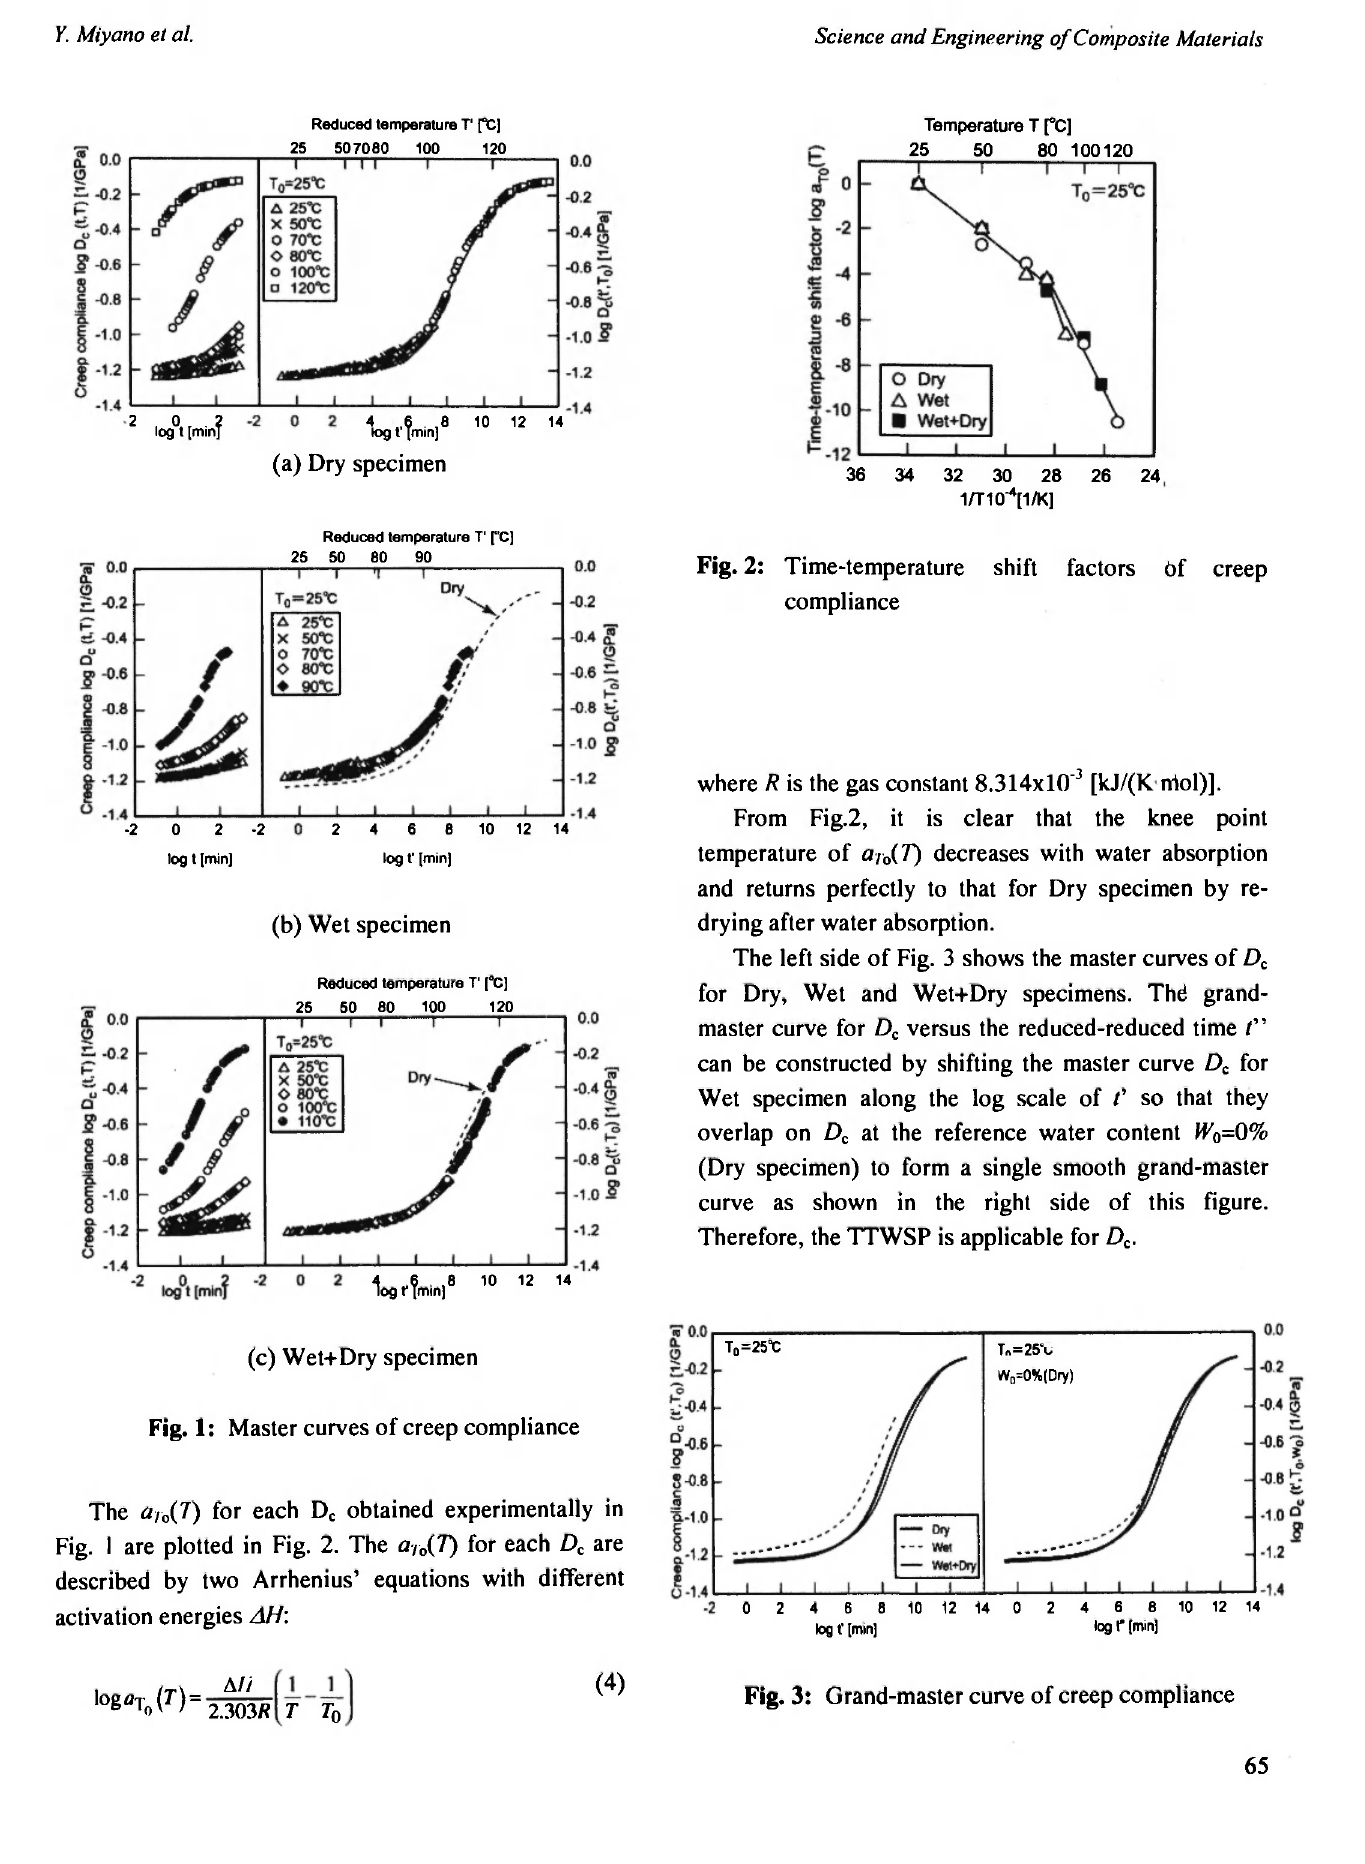
Fig. 3: Grand-master curve of creep